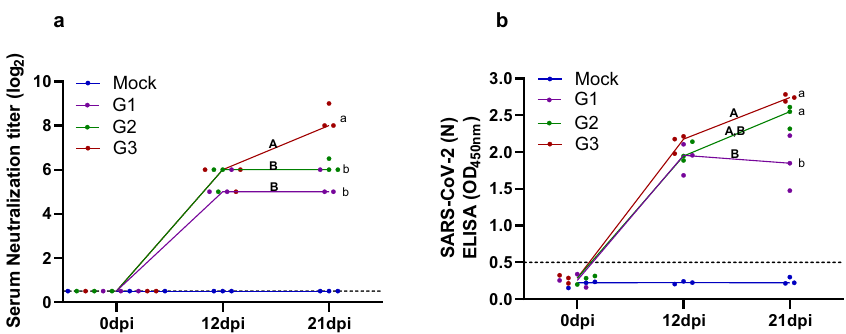
Fig. 4 Serum neutralizing antibody (NAb) and IgG antibody titers in different ages of ferrets. The NAb titers against SARS-CoV-2 NMC-nCoV02 (100 TCID 50 ) among different age groups was measured in Vero cells with serially diluted ferret sera collected at 0, 12, and 21 dpi ( a ). The IgG titers among different age groups in serially diluted sera collected at 0, 12, and 21 dpi ( b ). Groups with the same letter are of the same subgroup in the post-hoc analysis. Lower case letters indicate signi fi cant differences at each time point ( P values are a vs b: 0.00017 or 0.00168 ( a ), a vs b: 0.03 or 0.0044 ( b )), while upper case letters indicate signi fi cant differences of area under the curve as change over the entire period ( P values are A vs B: 0.0012 or 0.0233 ( a ), A vs B: 0.03 ( b )). The area under the curve was calculated using Kruskal – Wallis with Bonferroni as a post-hoc analysis. Data were analyzed in GraphPad Prism 9.1.2. Data are presented as mean ± SEM ( n = 3). The limit of detection for NAb titers and OD 450nm value is 0.5, indicated by the dotted line. Source data are provided as a Source Data fi